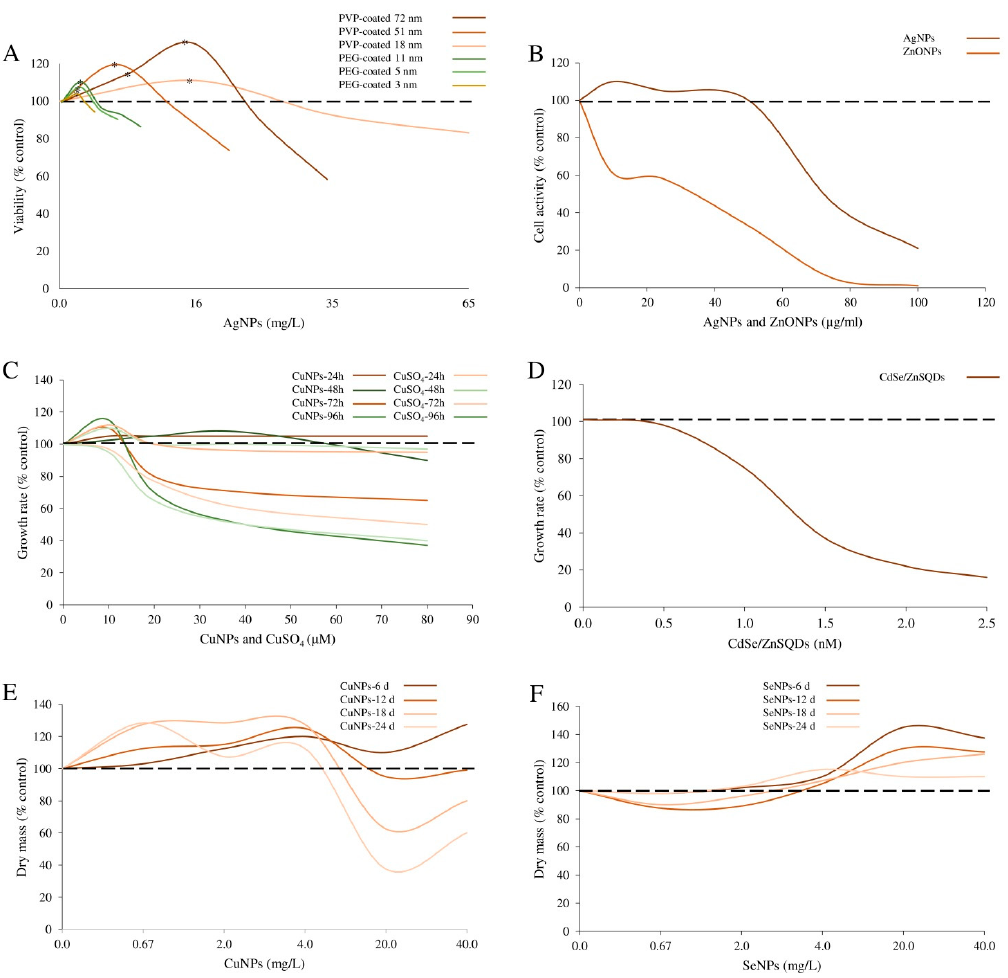
Figure 4. Influence of NP chemical composition on the induction of biphasic response. ( A ) In E. coli cells, the exposure both to PVP- and PEG-coated Ag-NPs induced a hormetic response (modified by Xiu et al. [16]). ( B ) In Caco2 cells exposed for 36 h to different concentrations of Ag-NPs and ZnO-NPs, the hormetic response was induced only by Ag-NPs (modified by Kang et al. [14]). ( C , D ) Cu-NPs at higher concentrations inhibited P. tricornutum growth, while at lower concentrations slightly stimulated growth (modified by Zhou et al. [23]). In the same experimental model, increasing concentrations of CdSe/ZnS-QDs did not induced a hormetic response (modified by Morelli et al. [46]). ( E , F ) Cu-NPs and Se-NPs induced a different kind of biphasic response related to the grown of Chlorella vulgaris (modified by Mykhaylenko and Zolotareva, [24]). * Indicates statistical significance ( p < 0.05). In line with these ideas, the role of physico-chemical properties, acquired by NPs when interacting with cell growth media or biological fluids, in affecting hormetic responses, should be elucidated in future investigations. Importantly, culture media, as well as physiological compartments, possess their own set of proteins that may be adsorbed on NPs when they interact with different physiological environments. This produces the so-called bio-molecular coronas that may change the biological identity of ENMs, supporting the need to further assess, in vivo, the contribution of diverse routes of exposure in affecting biphasic